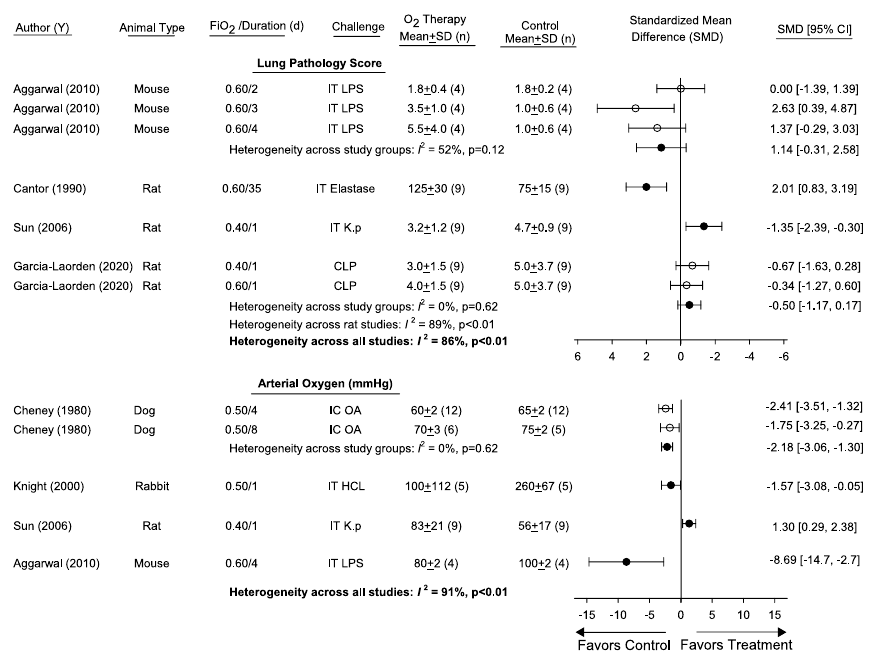
Fig. 3 Effects of FiO 2 s 0.60 and > O.21 (FiO 2 0.60/ > O.21) vs. FiO 2 s 0.21 (controls) on standardized ≤ ≤ = mean differences ( SD) (SMD) in pathology scores and arterial oxygen levels in studies [author (y)] that also ± administered animals an infectious or noninfectious inflammatory challenge. Animal type, FiO 2 level and duration, and inflammatory challenge route and type employed in studies are shown. Data from studies used to calculate SMDs for these parameters and parameter units are shown in Additional file 1: Table S2. Open circles represent results from individual regimens of oxygen or challenge within studies examining more than one regimen, that could be pooled ( I 2 level of significance, p 0.10) to report an overall SMD for the ≥ study, shown by solid circles. Results shown by the solid circles were then used to determine whether SMDs could be pooled across studies in the same species and then across all studies. Also shown are the number of animals ( n ) in study groups. Differences across studies for lung pathology scores ( I 2 86%, p < 0.01) and = across species for arterial oxygen levels ( I 2 91%, p < 0.01) prevented estimation of overall SMDs for either = parameter. CLP cecal ligation and puncture, IT intratracheal, IC intracardiac, K. p. Klebsiella pneumoniae , HCL hydrochloric acid, LPS lipopolysaccharide, OA oleic